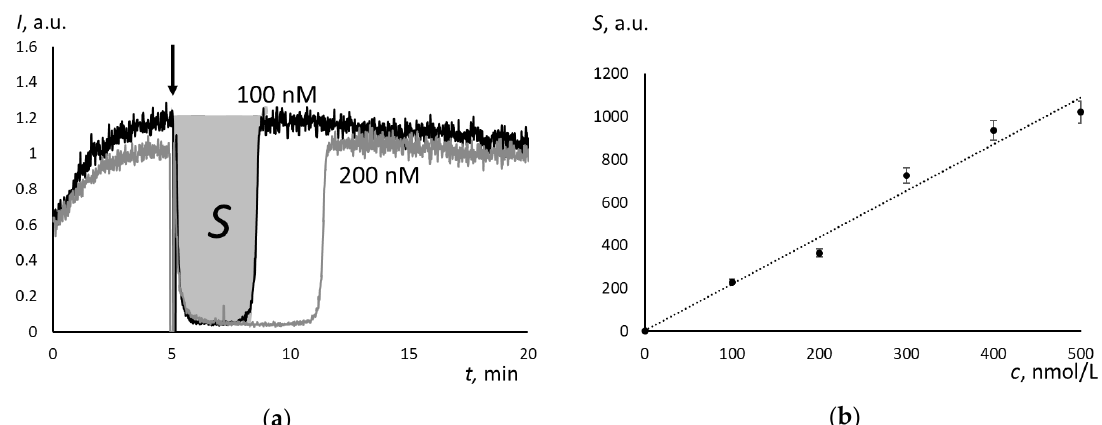
Figure 2. ( a ) Chemiluminograms for Trolox (concentrations are indicated in the figure), the chemiluminescent system consisted of 2.5 mM ABAP and 2 µ M luminol, the arrow shows the moment of the addition of Trolox, shaded is the area of the depression that is proportional to the number of scavenged free radicals; and, ( b ) The calibration plot of the depressed area on Trolox concentration, n = 5.